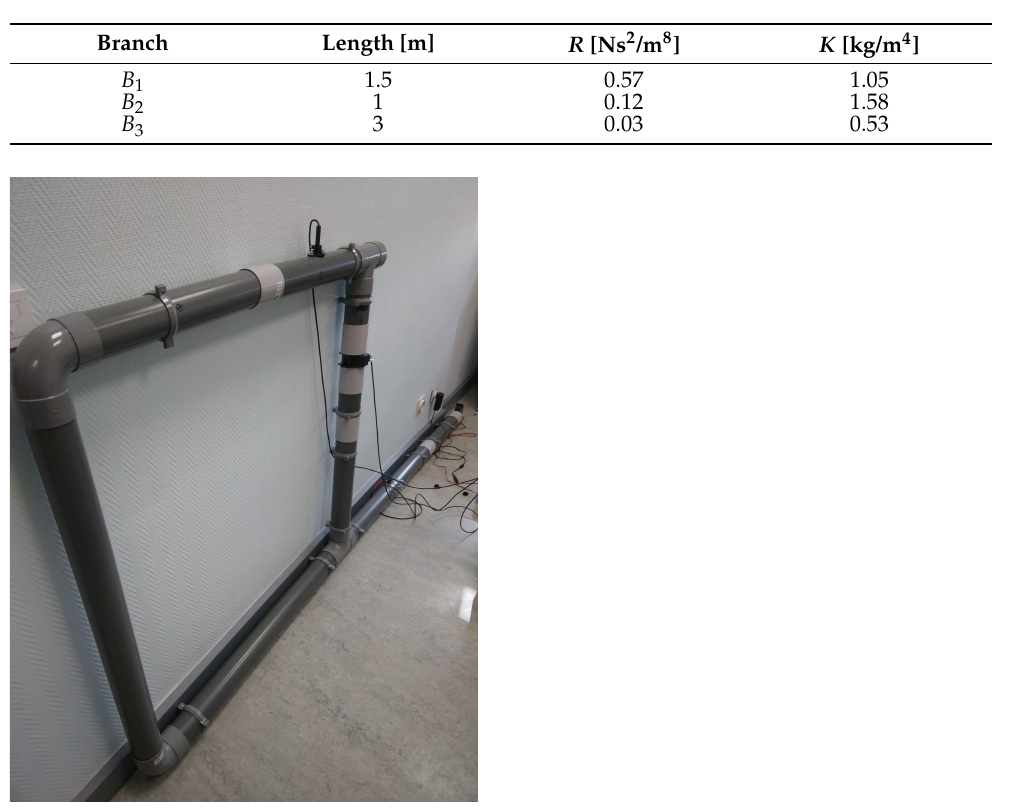
Table 3. Parameters of the ventilation network benchmark.